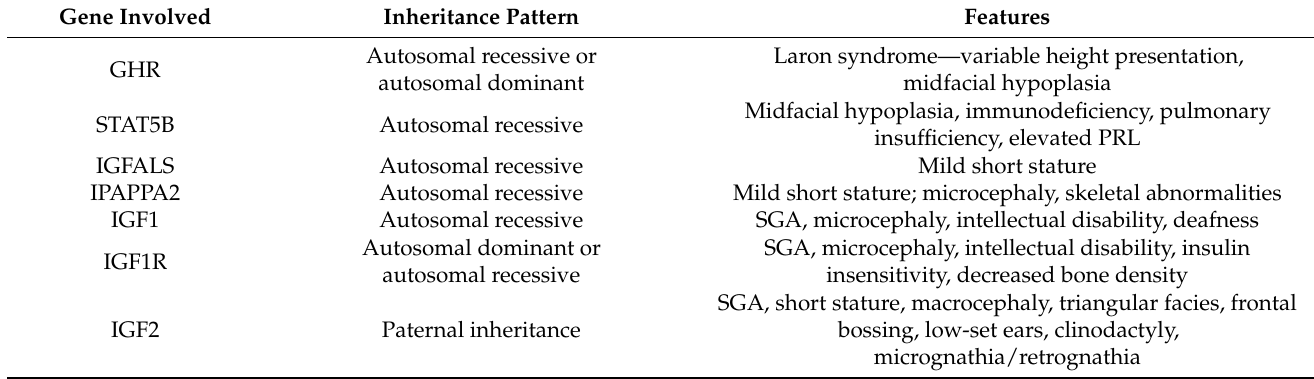
Table 2. GH insensitivity